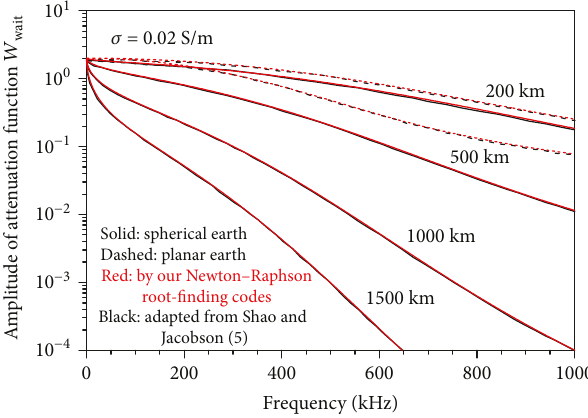
Black: adapted from Shao and Jacobson (5)